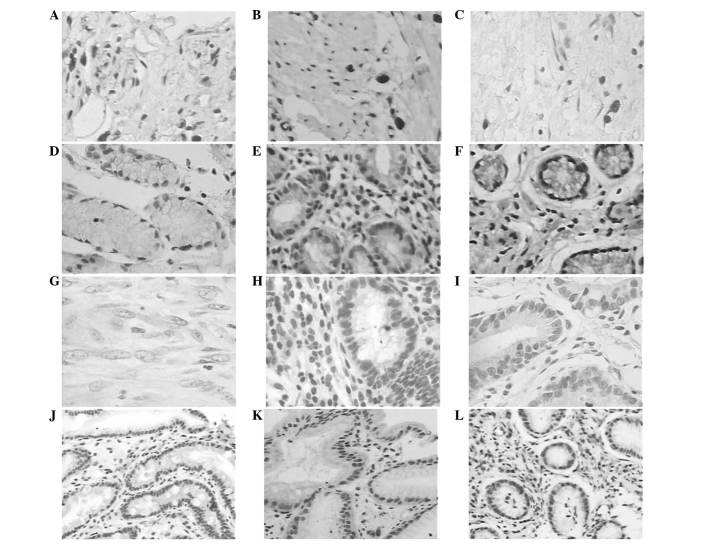
Expression of NICD and p21 proteins in gastric tissues, detected by immunohistochemistry. Expression of NICD protein in (A) poorly differentiated adenocarcinoma; (B) moderately differentiated adenocarcinoma; (C) well-differentiated adenocarcinoma; (D) precancerous gastric conditions, atrophic gastritis with intestinal metaplasia; (E) chronic superficial gastritis; and (F) normal gastric mucosa. Expression of p21 protein in (G) poorly differentiated adenocarcinoma; (H) moderately-differentiated adenocarcinoma,; (I) well-differentiated adenocarcinoma; (J) precancerous gastric conditions, atrophic gastritis with intestinal metaplasia; (K) chronic superficial gastritis; and (L) normal gastric mucosa (magnification, ×400). NICD, Notch1 intracellular domain.